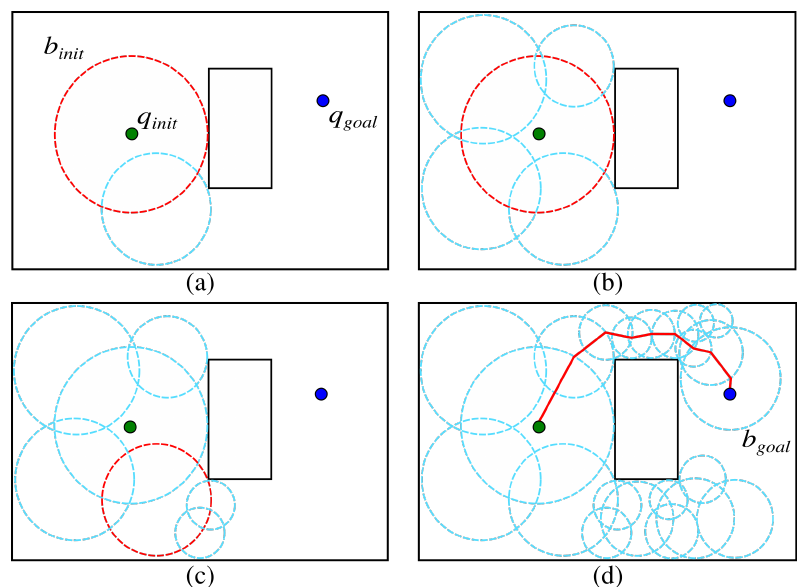
Figure 2. PFM propagation from initial (green dot) to goal configuration (blue dot). ( a ) Initial parent bubble (red circle) and first child bubble. ( b ) Four possible children bubbles. ( c ) New PFM generation with parent bubble selected and children bubbles expanded. ( d ) Probabilistic foam and path found.